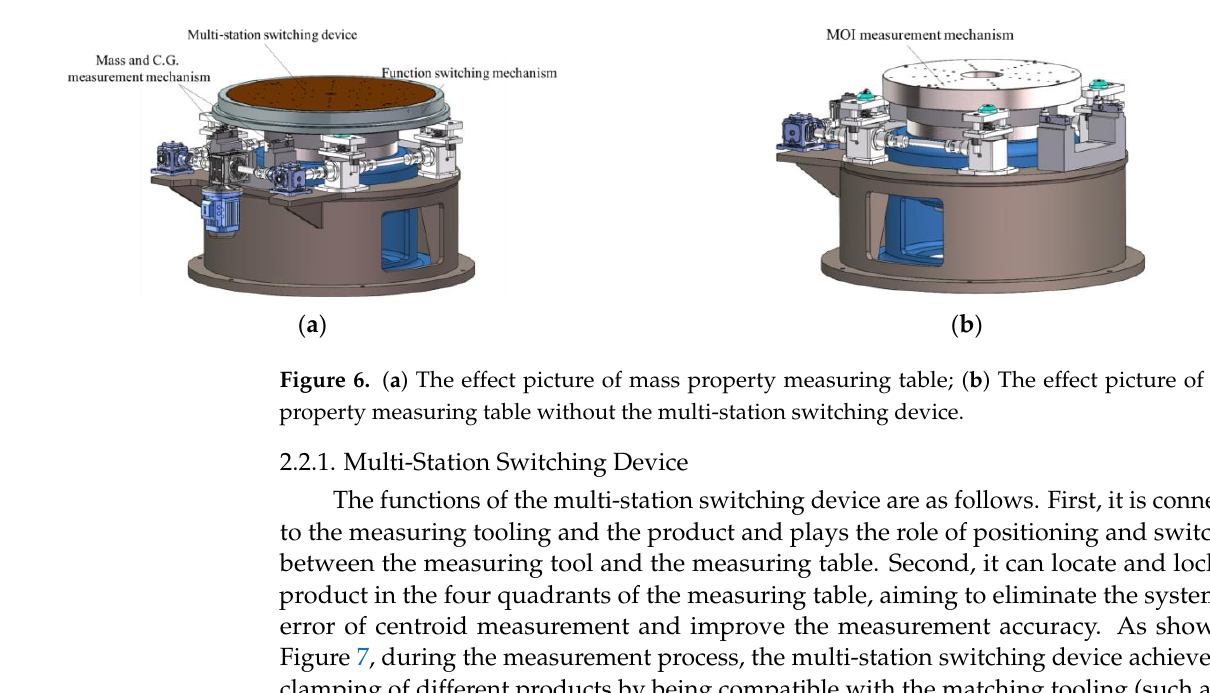
( b ) Figure 5. ( a ) Overall effect of the equipment — horizontal state; ( b ) overall effect of the equip-